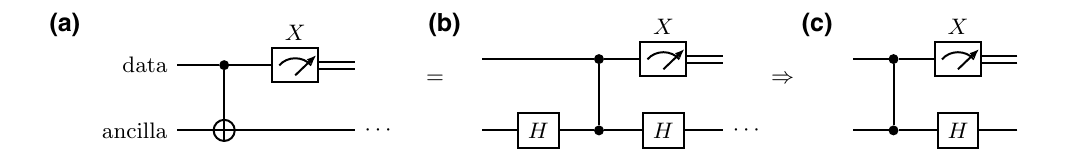
FIG. 6. A diagram showing the reason why bit-error correction does not change phase errors. In the showcase, we take a pair of CNOT gates as an example. In the figures, we only depict the circuit on Alice’s side and the circuit is the same on Bob’s side. Here, the control qubit is one of the data qubits and the target qubit is one of the ancillary qubits, as shown in Fig. 5. The equivalence of (a)–(c) comes from the fact that σ x = H σ z H and H ⊗ 2 | (cid:6) + (cid:2) = | (cid:6) + (cid:2) .